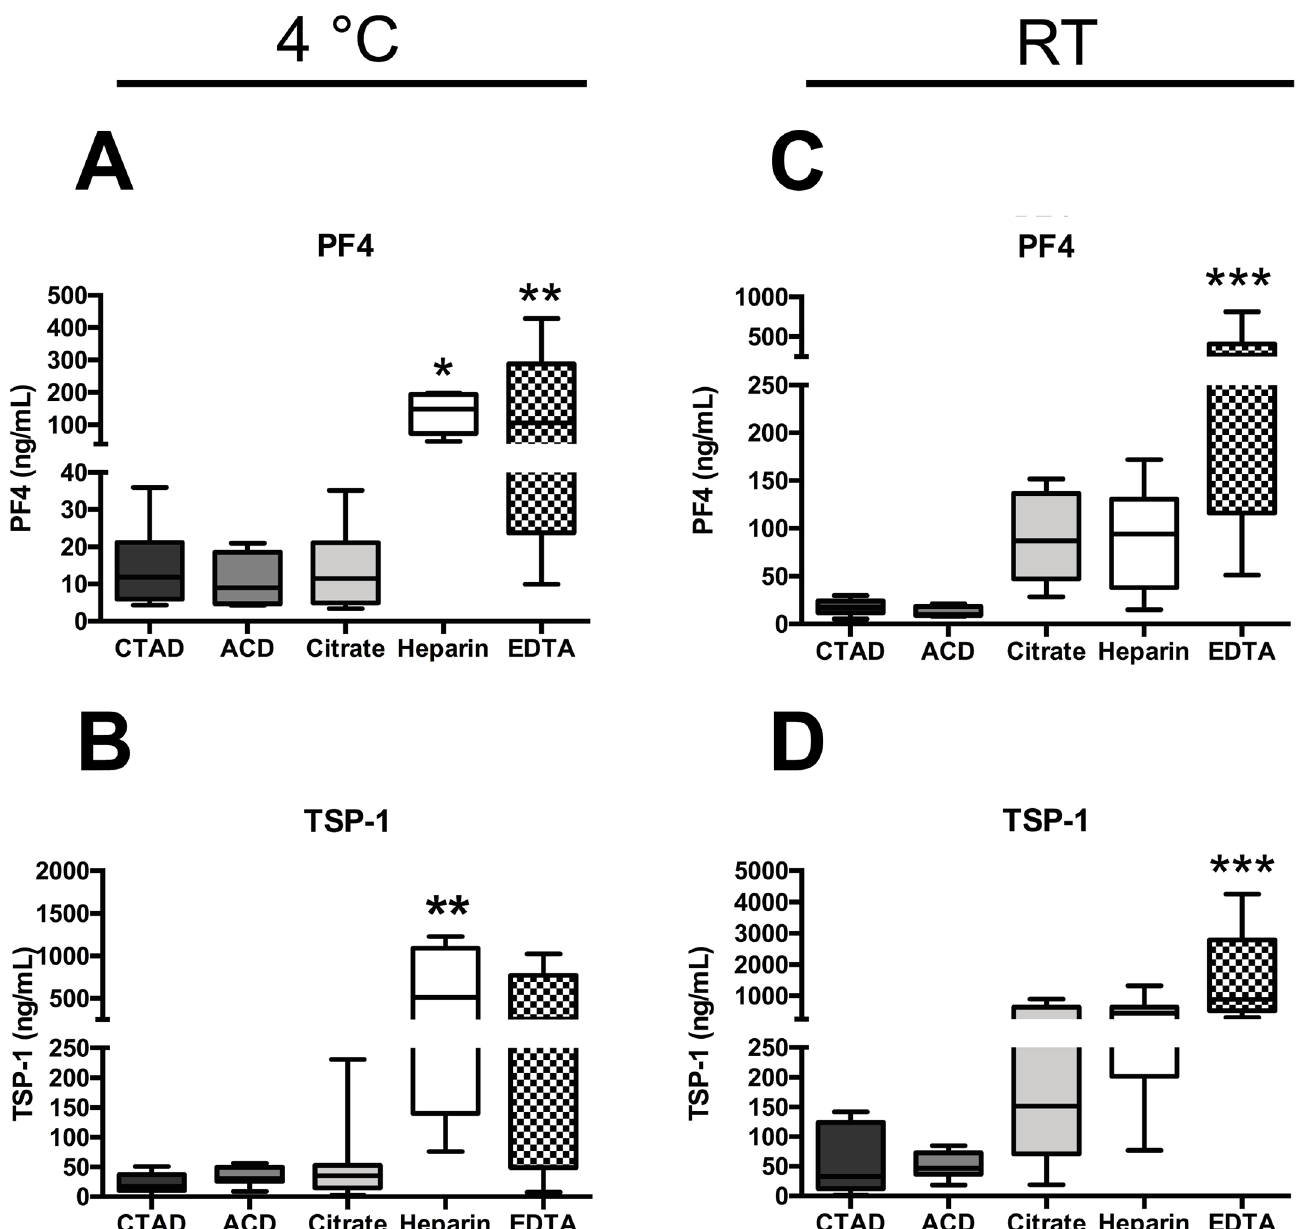
Fig 2. Plasma levels of platelet-stored factors vary among different anticoagulants. Plasma levels of PF4 (A, C) and TSP-1 (B, D) were determinedin 8 healthyindividuals. Plasma was preparedfrom CTAD (black bar), ACD (dark grey bar), citrate (grey bar), heparin(white bar) or EDTA (patternedbar) bloodat 4˚C (A-B) or at room temperature (C-D) within 30 min after blood draw. Plasma concentration was measuredusing ELISA. Significantdifferences were analyzedusing one-wayANOVA with Dunnett correction and were depicted as * p < 0.05, ** p < 0.01, *** p < 0.001(in comparisonto